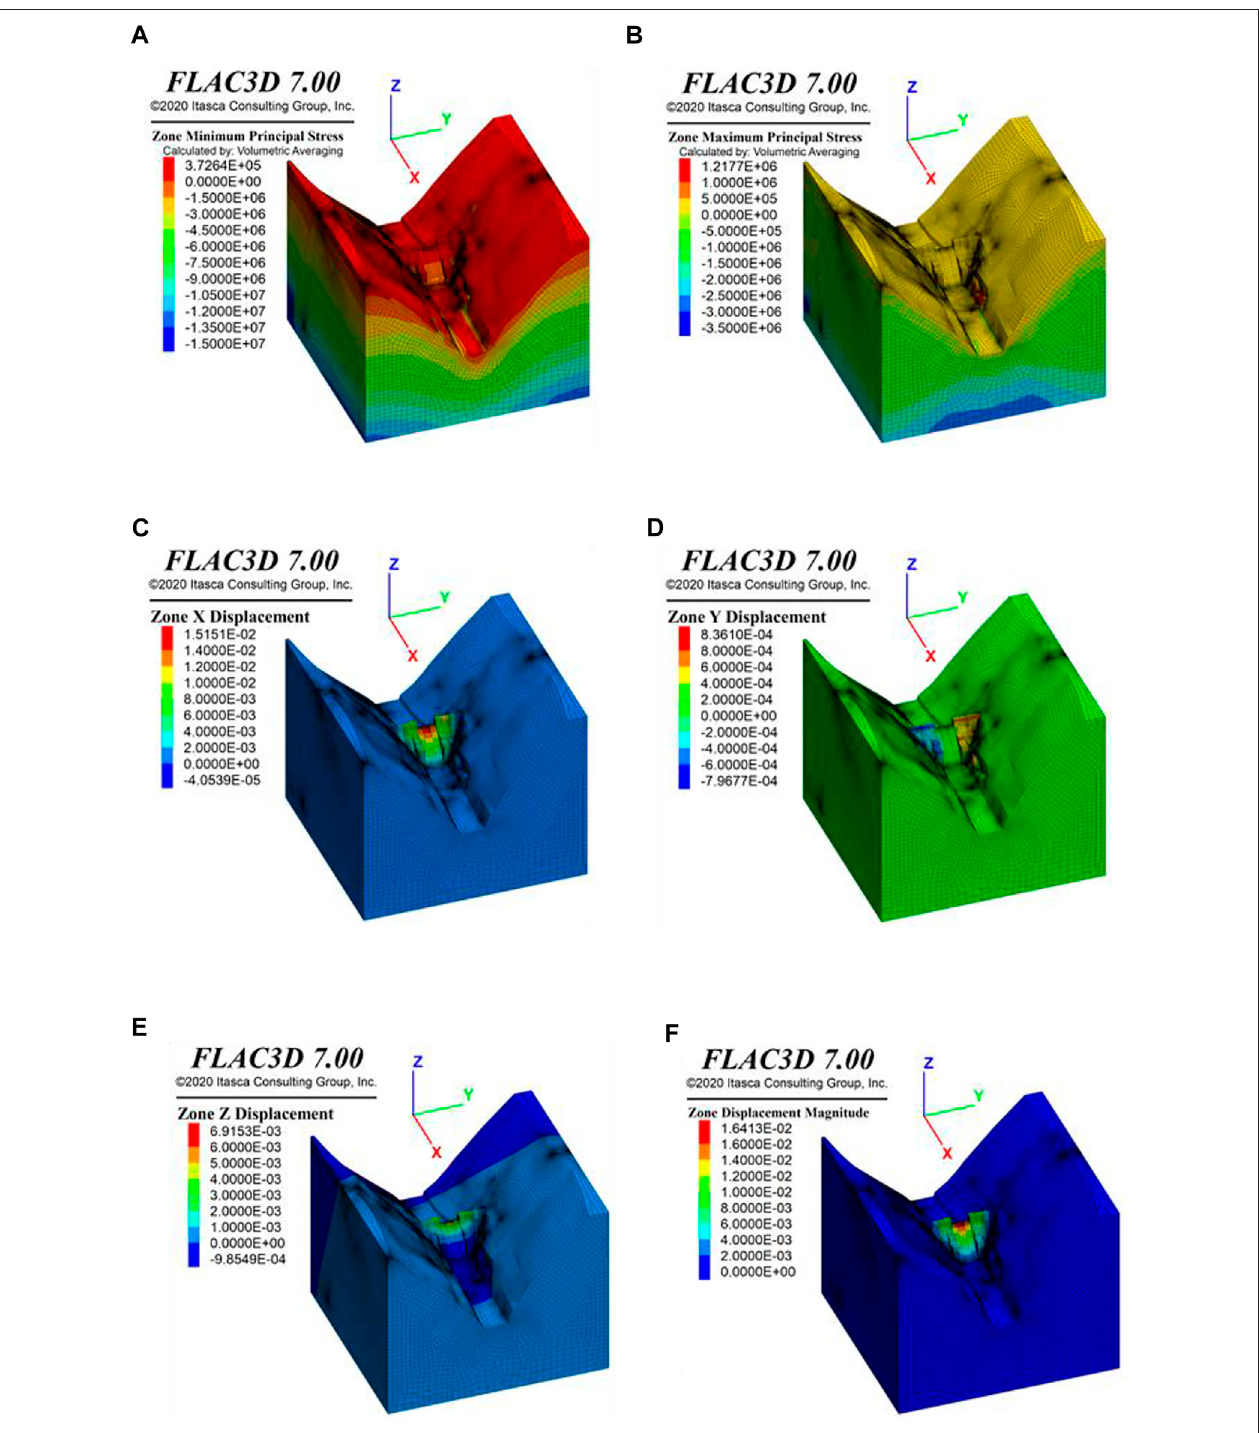
FIGURE 4 | The simulation results of the holistic model under the condition of normal water level: (A) Major principal stress. (B) Minor principal stress, (C) Displacement along the river (Xdisp). (D) Displacement across the river (Ydisp). (E) Vertical displacement (Zdisp). (F) Resultant displacement (Rdisp).